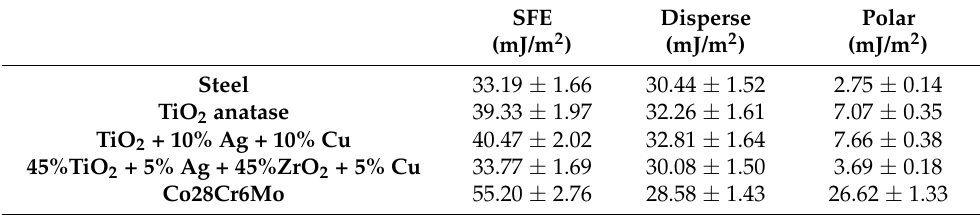
Table 1. Surface free energy (SFE) of different fabricated